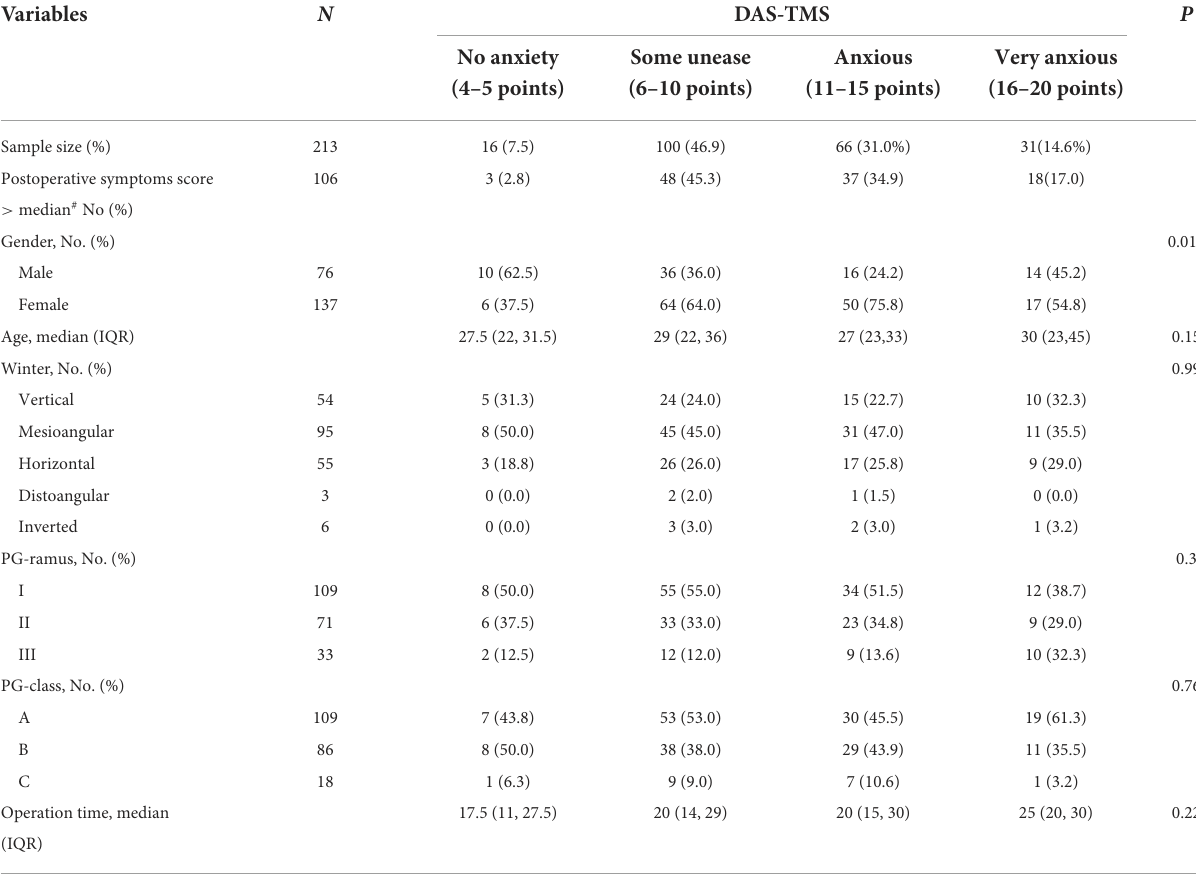
TABLE 1 Baseline characteristics of the study population for total samples and subgroups according to categories of DAS-TMS * .